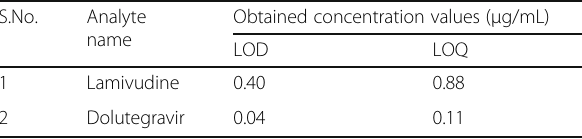
Table 3 Limit of detection and limit of quantification S.No.